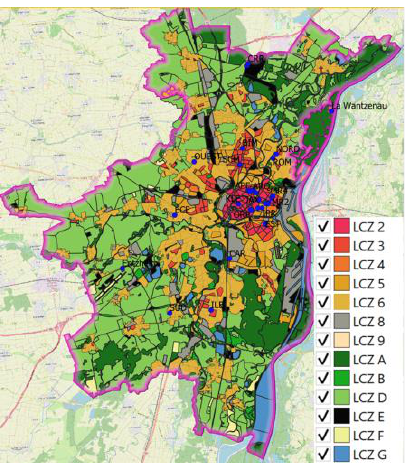
Figure 1. Local Climate Zone map and of the Eurometropolitan area of Strasbourg.